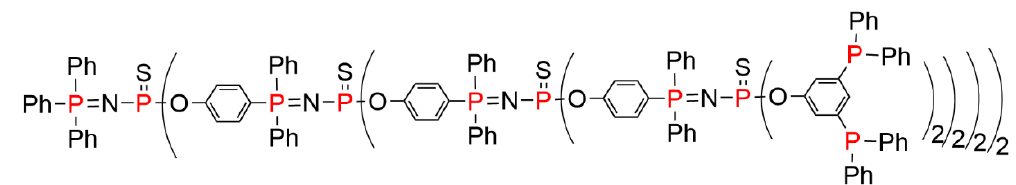
Figure 8. Full chemical structure of the dendrimer 14-G5 shown in a linear form in Scheme 14. Exactly the same process was applied later to triphenylphosphine used as core. The synthesis was carried out up the third generation, functionalized by diphosphines on the surface, as shown in Figure 9 [34].